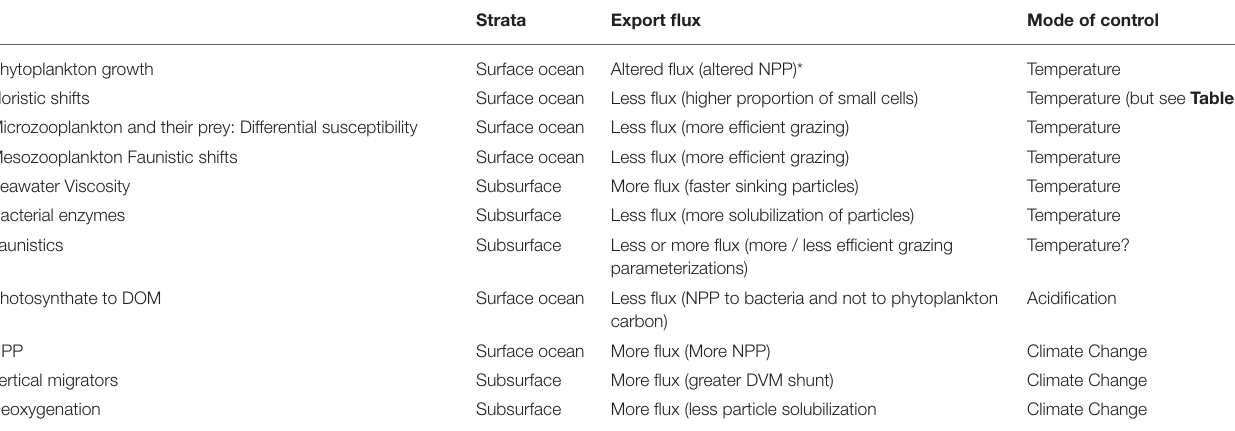
TABLE 6 | Summary of the coupling of individual processes used in model runs presented in Figures 6,